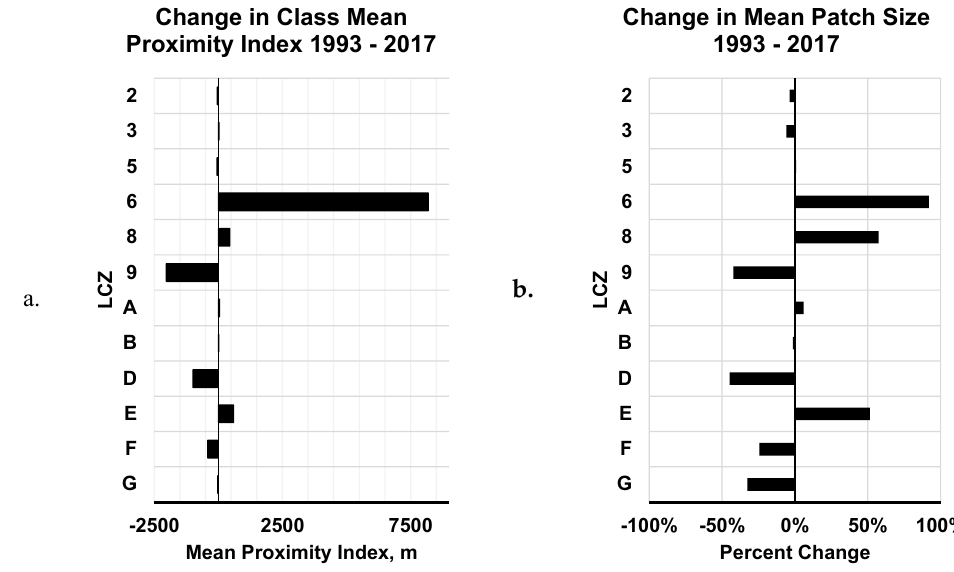
Figure 6. Changes in spatial pattern indicators of different LCZs from 1993 to 2017: ( a ) mean proximity index, and ( b ) mean patch size.